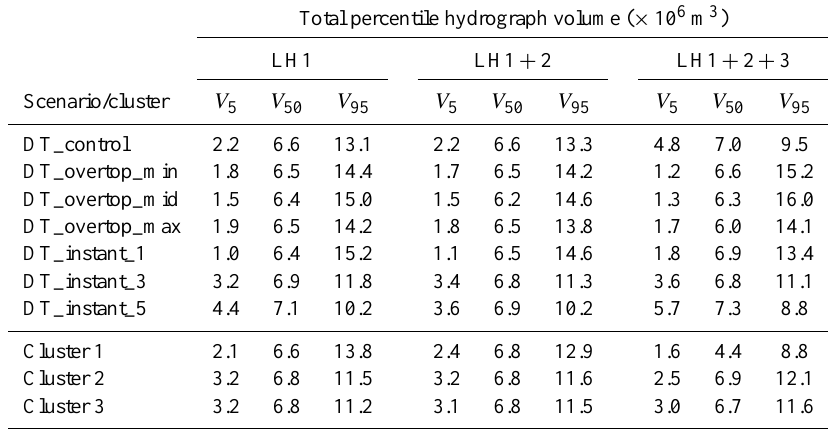
Table 4. Total percentile hydrograph outflow volumes for individual scenarios and following